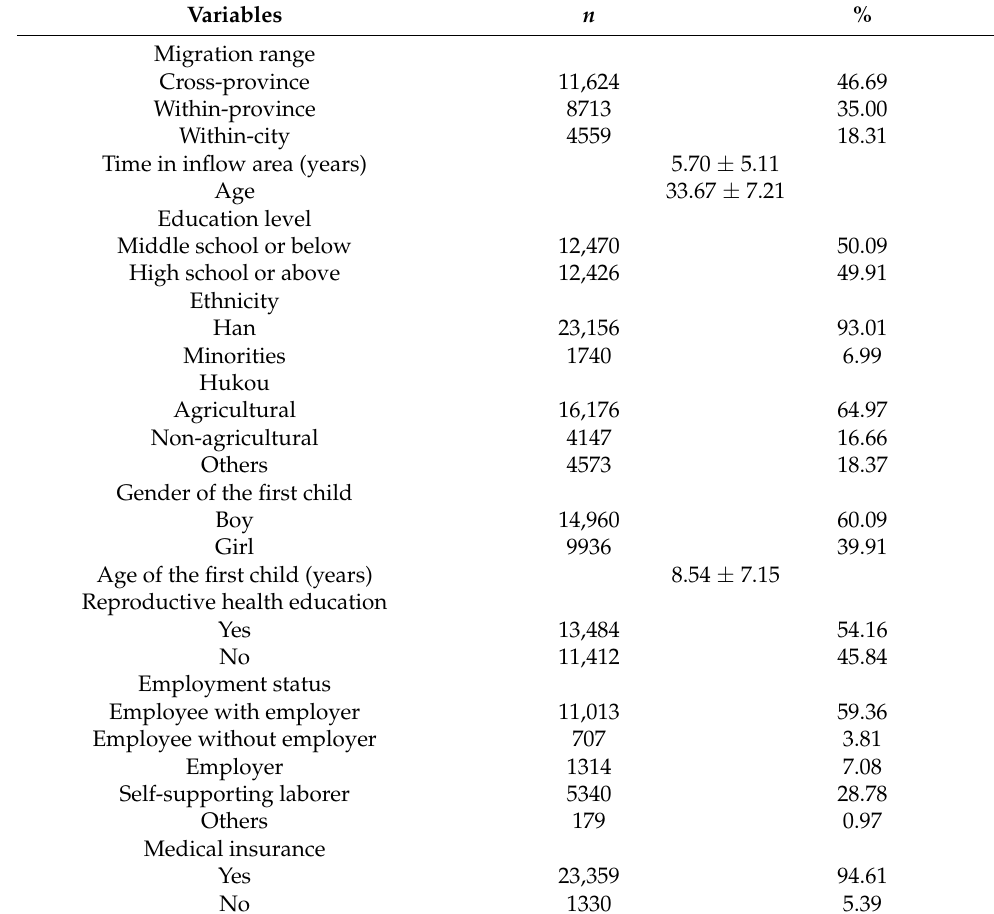
Table 1. Characteristics of the participants ( N =